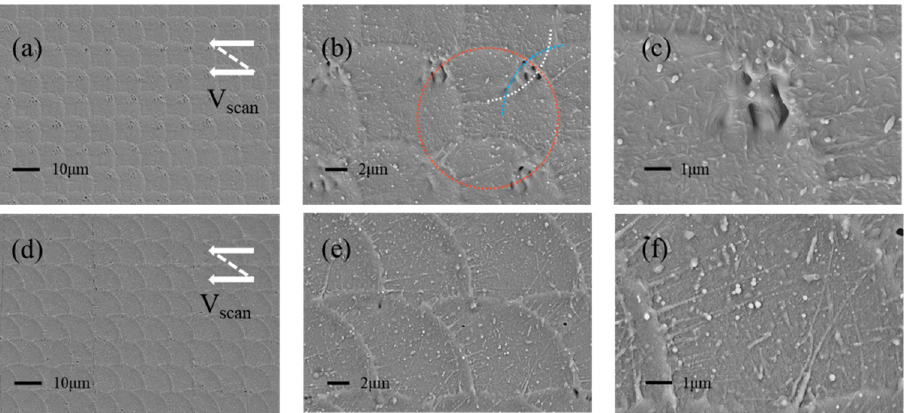
Figure 5. SEM images of infrared laser-textured glass at different laser energy densities. ( a – c ) the laser energy density is 57.3 J/cm 2 , ( d – f ) the laser energy density is 95.5 J/cm 2 .